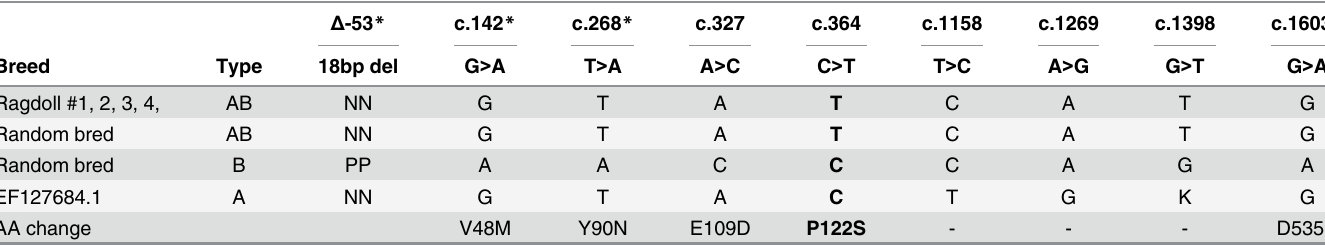
Table 1. Comparison of CMAH cDNA variants in cats with blood types A, B and